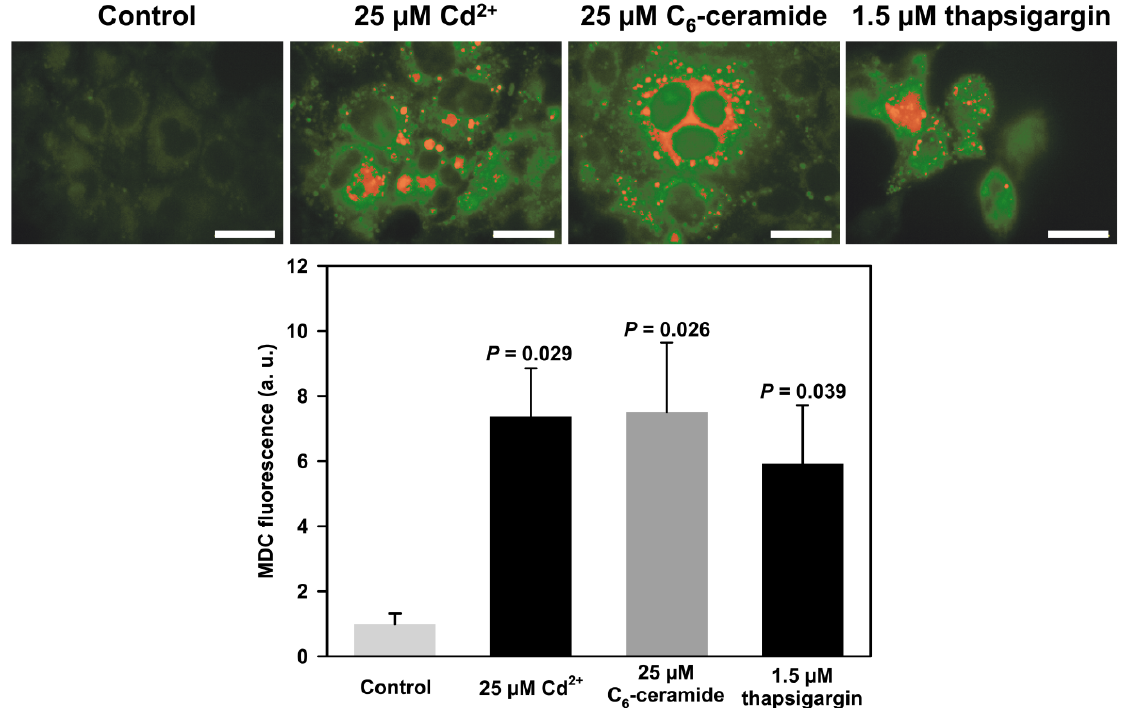
Figure 2. Autophagosome formation induced by Cd 2+ , C6-ceramide, or thapsigargin in PT cells. WKPT-0293 Cl.2 cells were incubated for 1 h with Cd 2+ , C6-ceramide, or the ER-stress inducer thapsigargin prior to monodansylcadaverine (MDC; 10 µM) fluorescence staining (upper panels). During the experimental period cells were incubated in culture